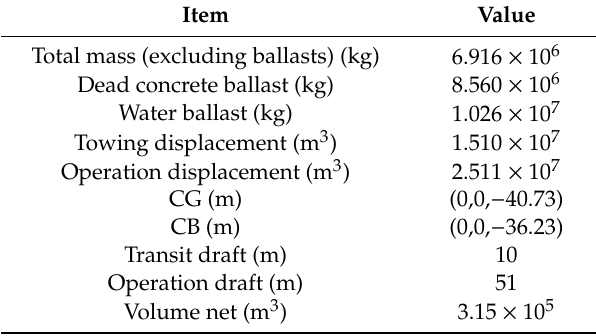
Figure 6. Ballast arrangement. Table 4. Parameters of the wind–solar–aquaculture system (WSA) in static equilibrium position. CG—center of gravity; CB—center of buoyancy.